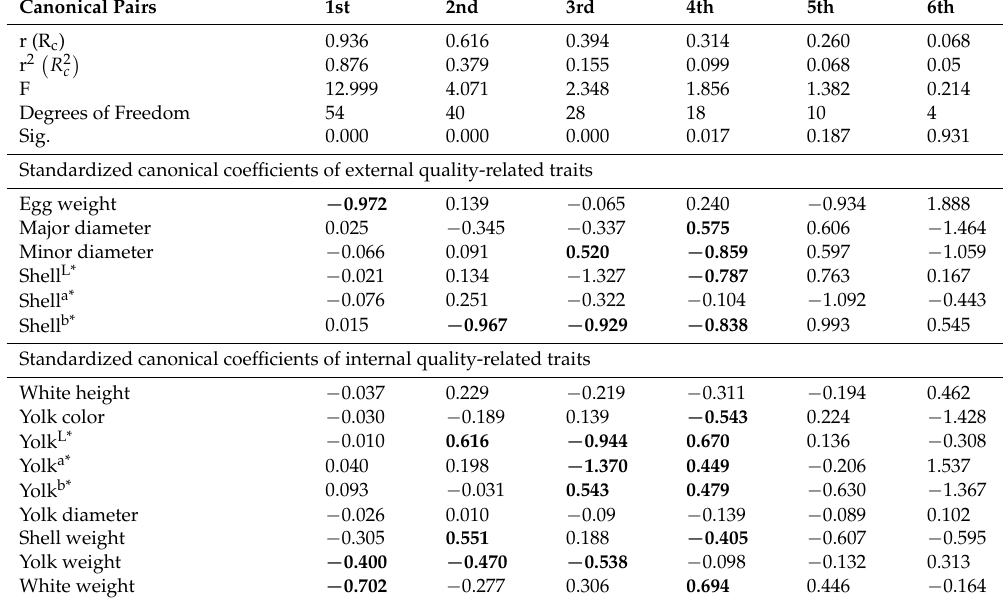
Table 3. Standardized canonical coefficients of variables, canonical correlations between two sets of variables (r), squared canonical correlation (r 2 ) and their probabilities (F) for internal and external egg quality-related traits, excluding yolk and white pH, in Utrerana hens compared to laying lineage (n = 194).